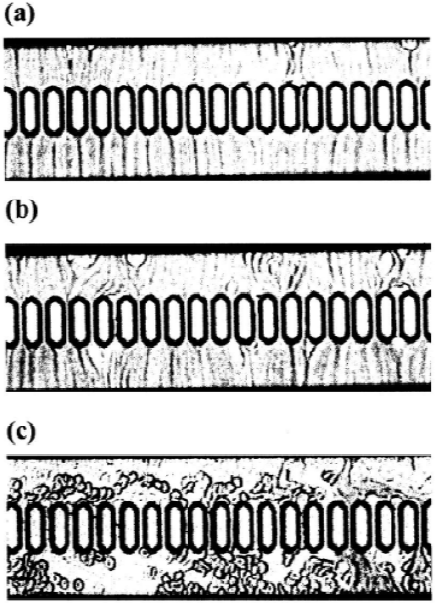
Figure 17. Microscopic details of blood samples passing through individual micro-channel arrays of the micro-channel array flow analyzer (MC-FAN), redrawn from Sugawara et al. [24]. ( a ) View of a temperature-untreated sample with a transit time = 12.6 s and transit sample volume = 25 μ L. ( b ) Identical temperature-untreated with a transit time = 27.8 s and transit sample volume = 50 μ L; ( c ) View of an identical blood sample to that in (a) and (b) but subjected to mild heating at 45 °C for 30 min prior to application to MC-FAN with a transit time = 120.7 s and transit sample volume = 30 μ